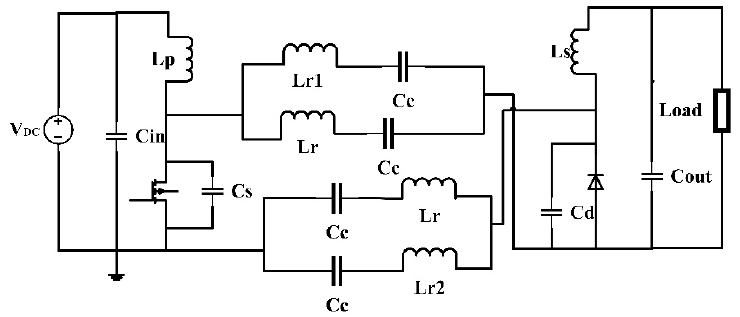
Figure 3. Class-E 2 with 8-plate multi-resonant coupling structure.